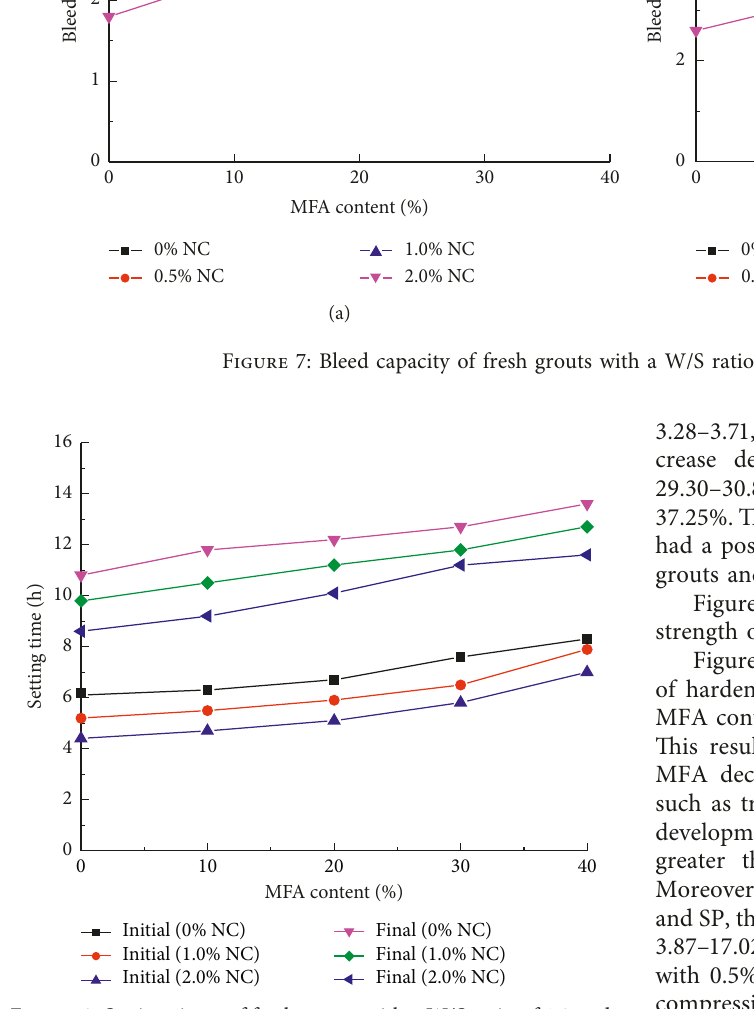
Figure 8: Setting times of fresh grouts with a W/S ratio of 1.2 and 1.5%